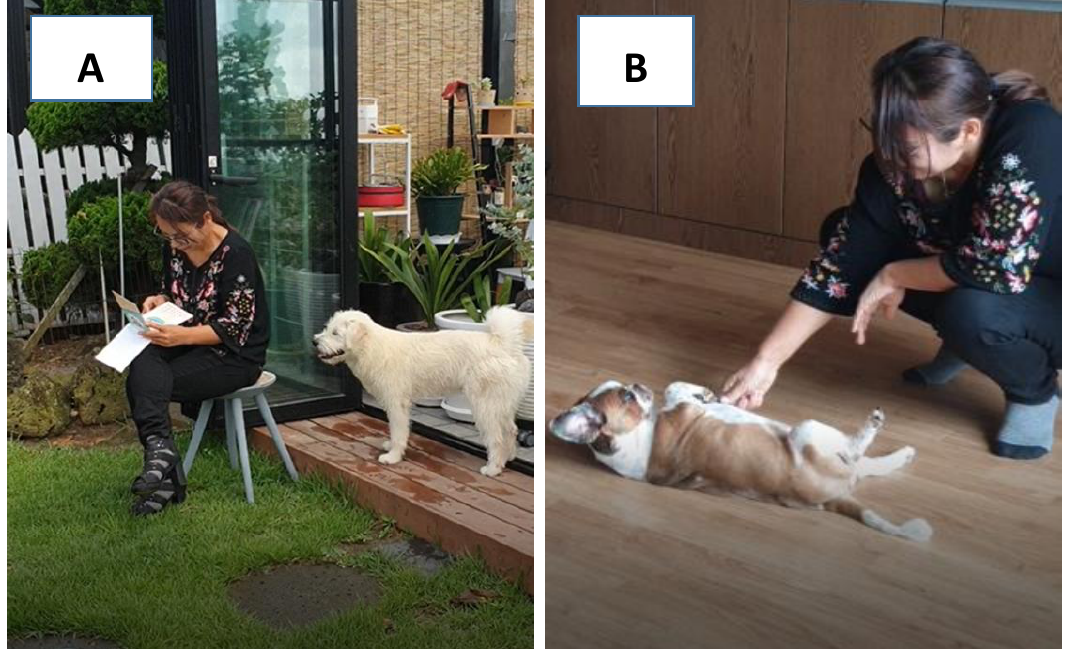
Figure 1. ( A ) Evaluation of the passive phase for sociality test (Step 1) and ( B ) Evaluation of the active phase for sociality test (Step 2).